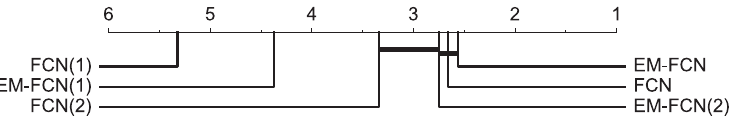
Figure 9. Critical difference diagram of a pairwise statistical difference comparison of EM-FCN and FCN with different numbers of layers.